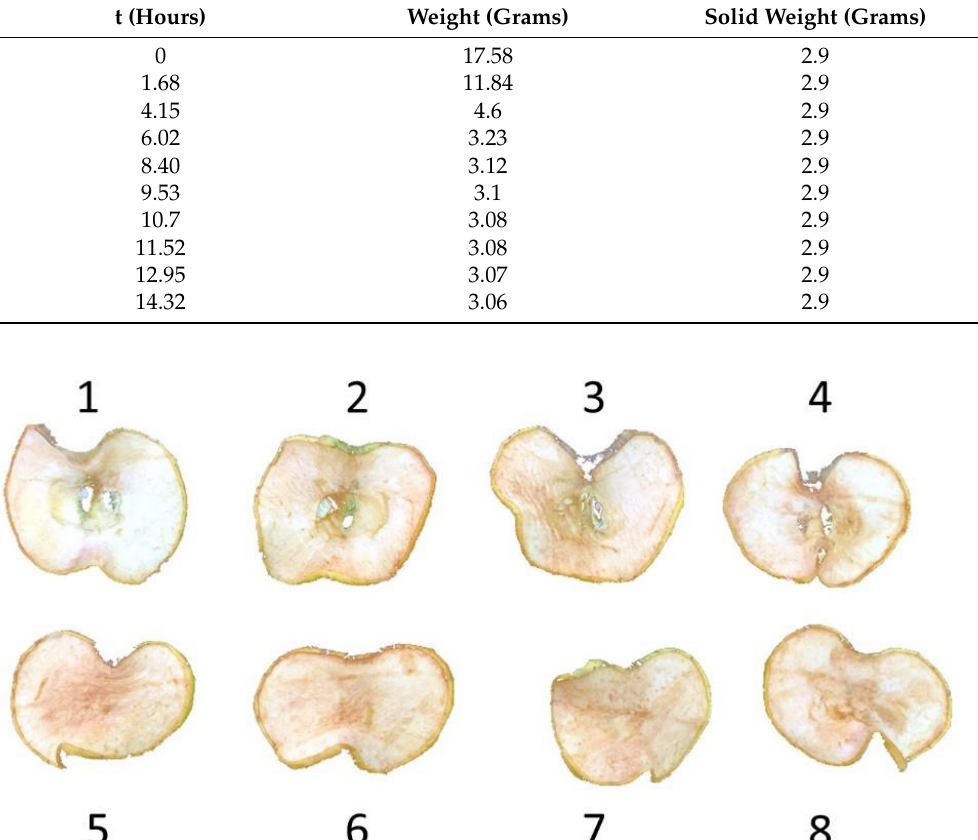
Table 1. Measurements of moisture attributes for the first apple slice during the dehydration process at nine instances of time.